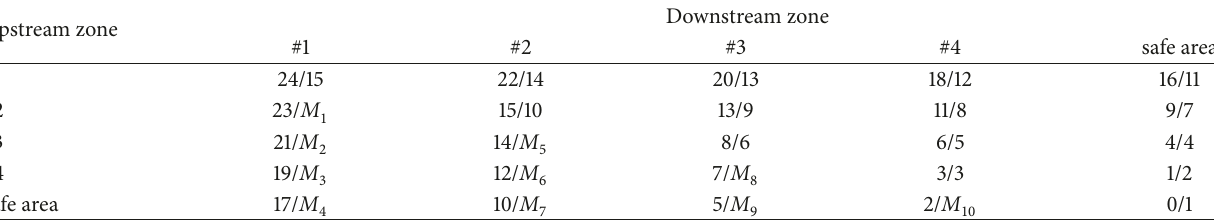
Table 7: Road risk level/weight coefficient according to improved